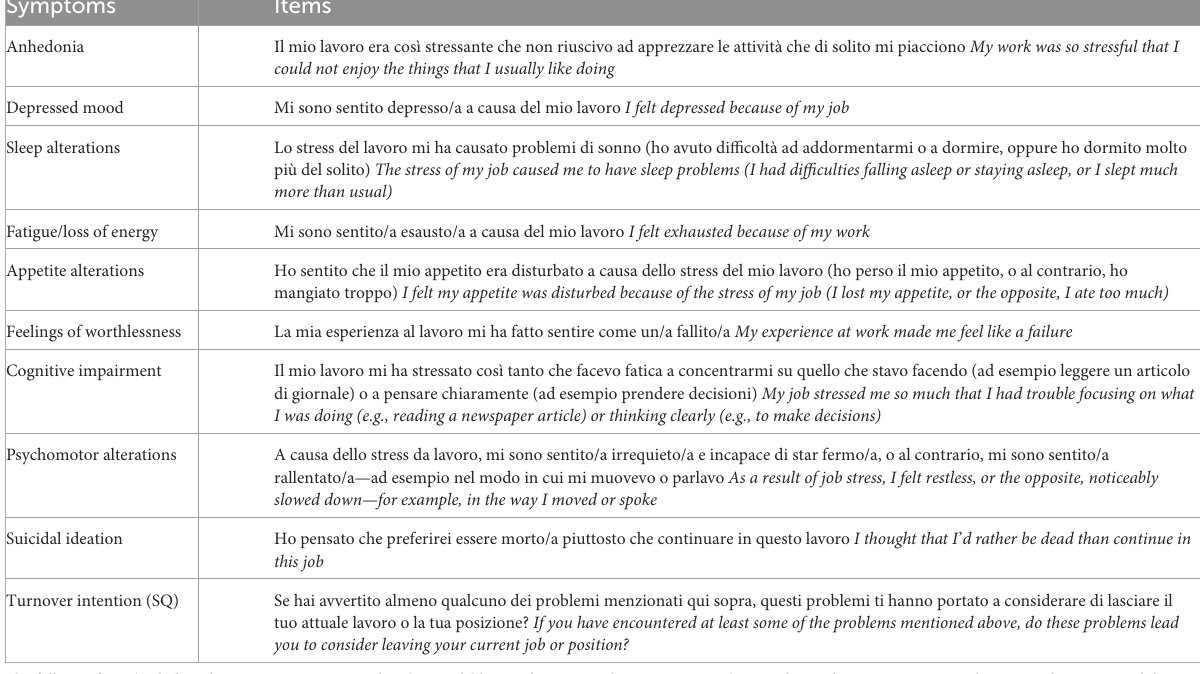
TABLE 1 Italian version of the items of the Occupational Depression Inventory (ODI). Symptoms